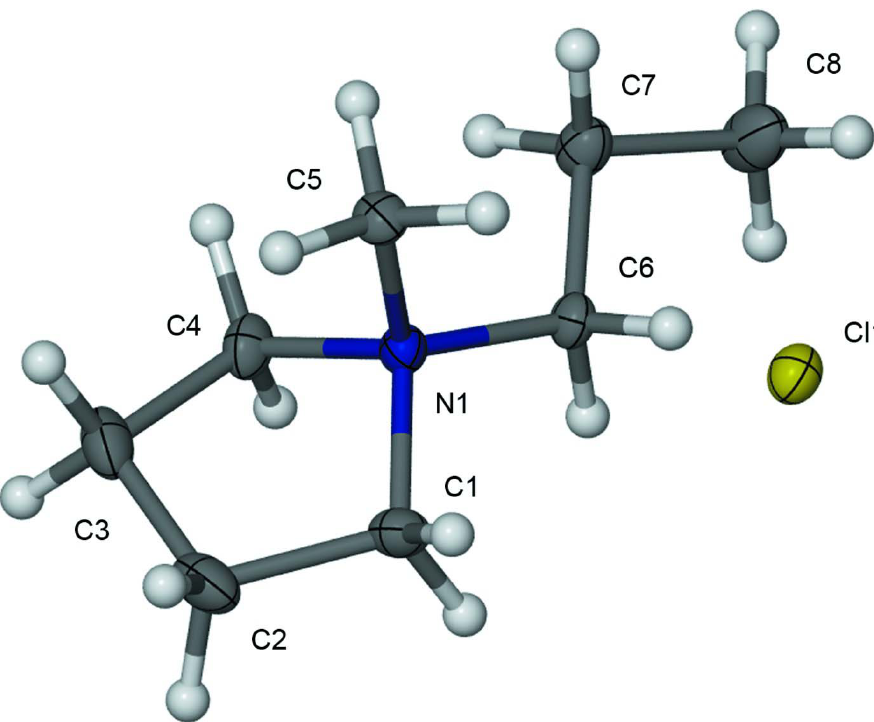
Figure 1 Diagram of the unique component of (I) shown with 50% thermal ellipsoids and hydrogen atoms as spheres of arbitrary